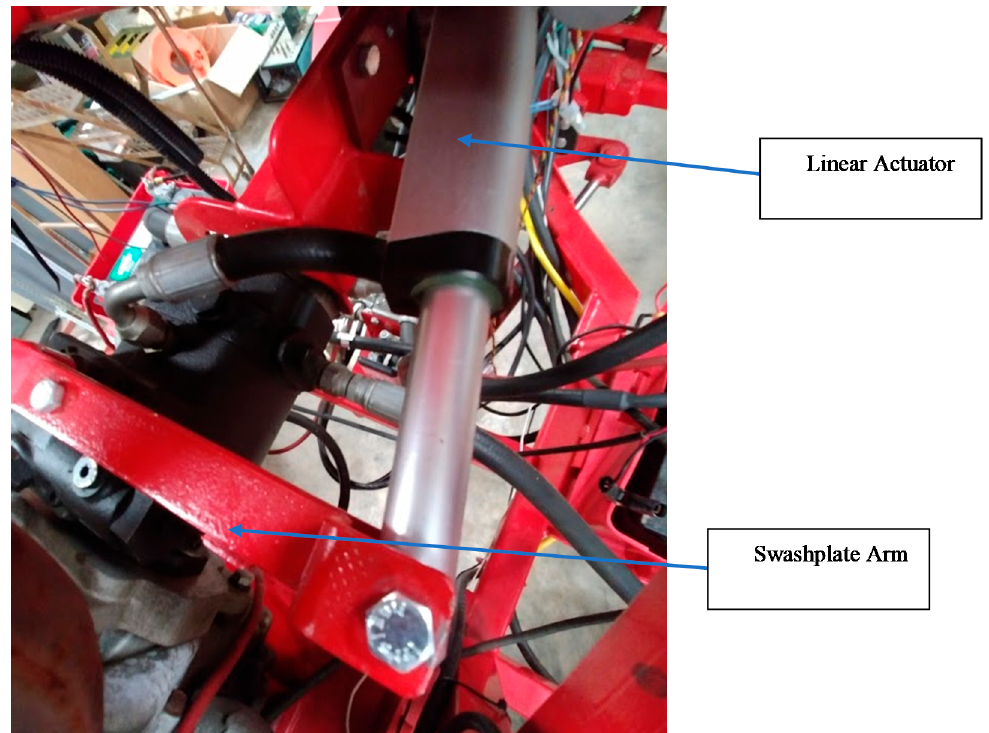
Figure 15. The linear actuator moving the swashplate arm to determine an angle for movement of the rover (forward when extending or rearward when retracting).